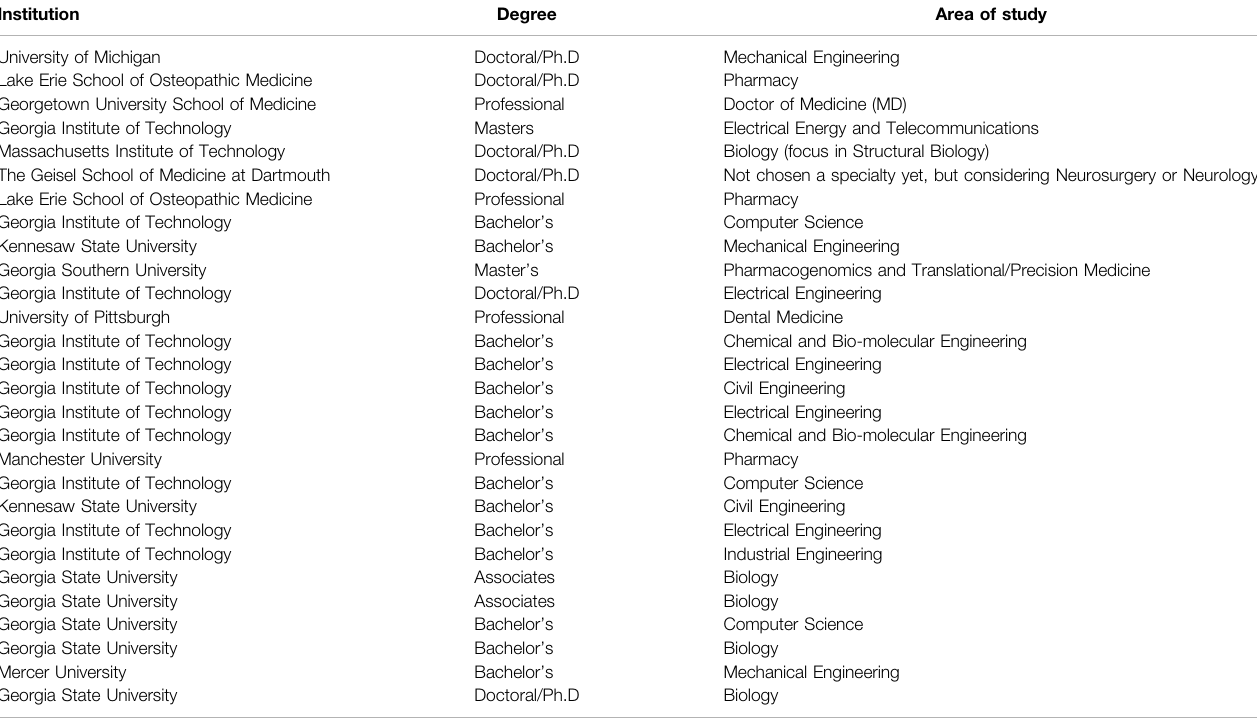
TABLE 5 | Information from Transfer Bridge Alumni Currently Enrolled in.